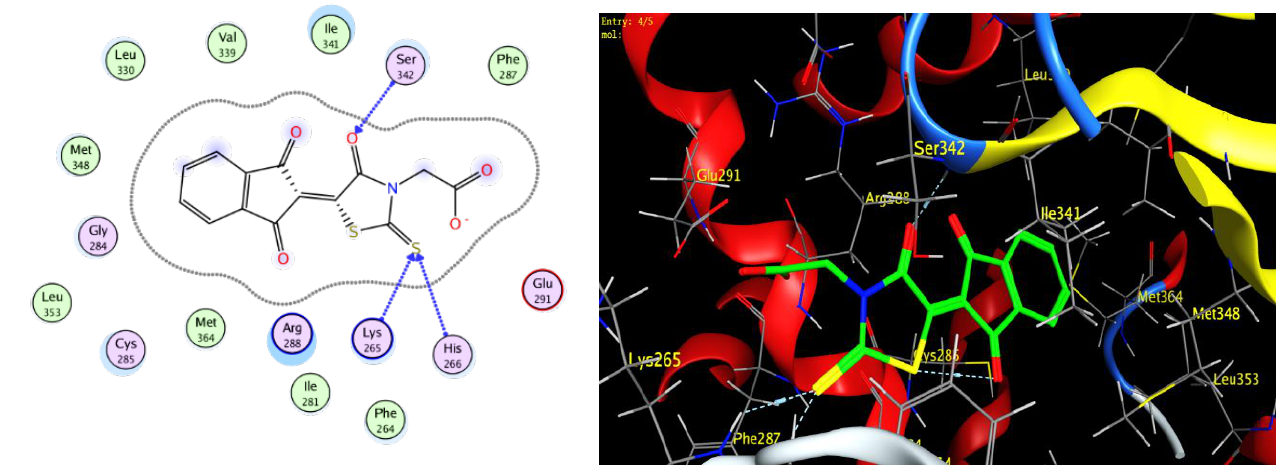
Figure 5. 2D and 3D docking of compound 5c with PPAR γ . Compound 5d modeling configuration with AKR1B1 shows hydrogen bonding inter- action with ASN 161 and hydrophobic interactions with SER 211 and TYR 210 (Figure 6).